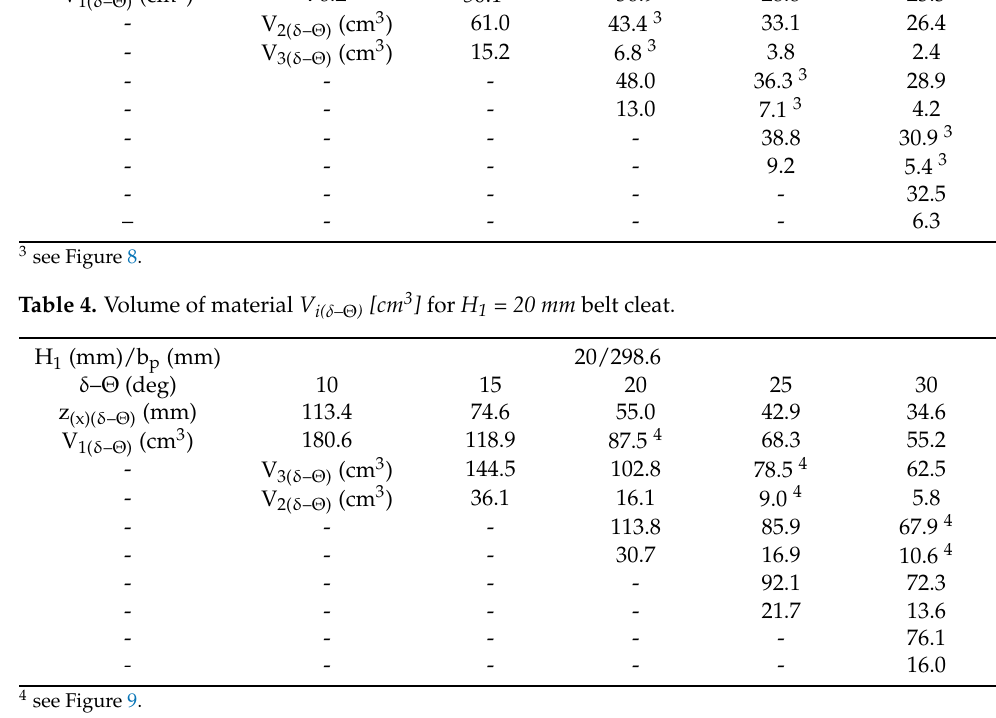
Figure 9. Batch volume V 3( δ–Θ ) material, spread on the conveyor belt, retained by a belt cleat with a height of H 1 = 20 mm.